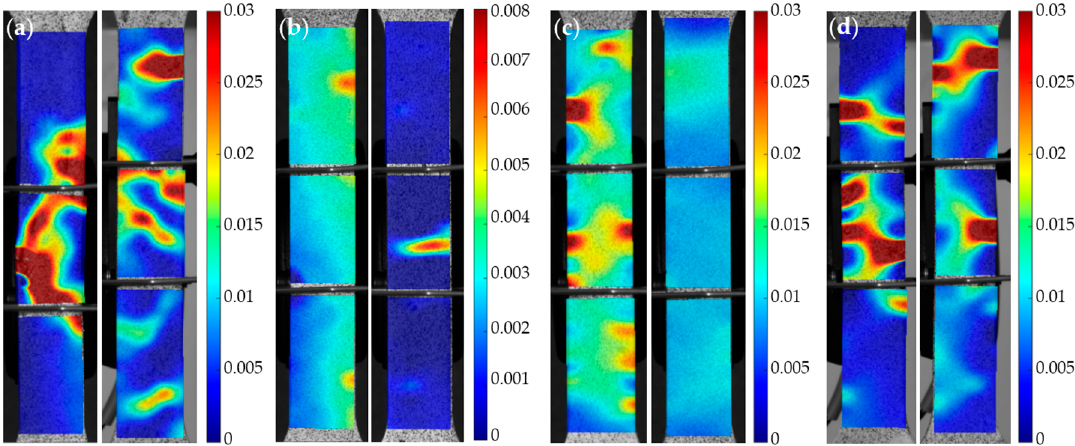
Figure 9. Longitudinal Eulerian strain concentrations for a selected 144- and 288-h sample of ( a ) Type 430, ( b ) Type 17-4, ( c ) Type 316, and ( d ) Type 304 stainless steel at a global strain of 1.5%.